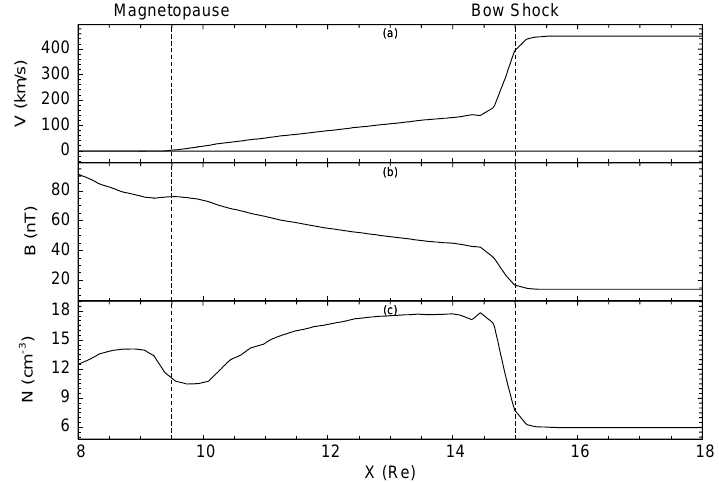
Fig. 12. Some parameters along the Sun-Earth line for Run 2. From top to bottom are: the flow speed, the magnetic field magnitude, and the plasma density. The magnetopause is defined as the location where the flow speed in the magnetosheath approaches